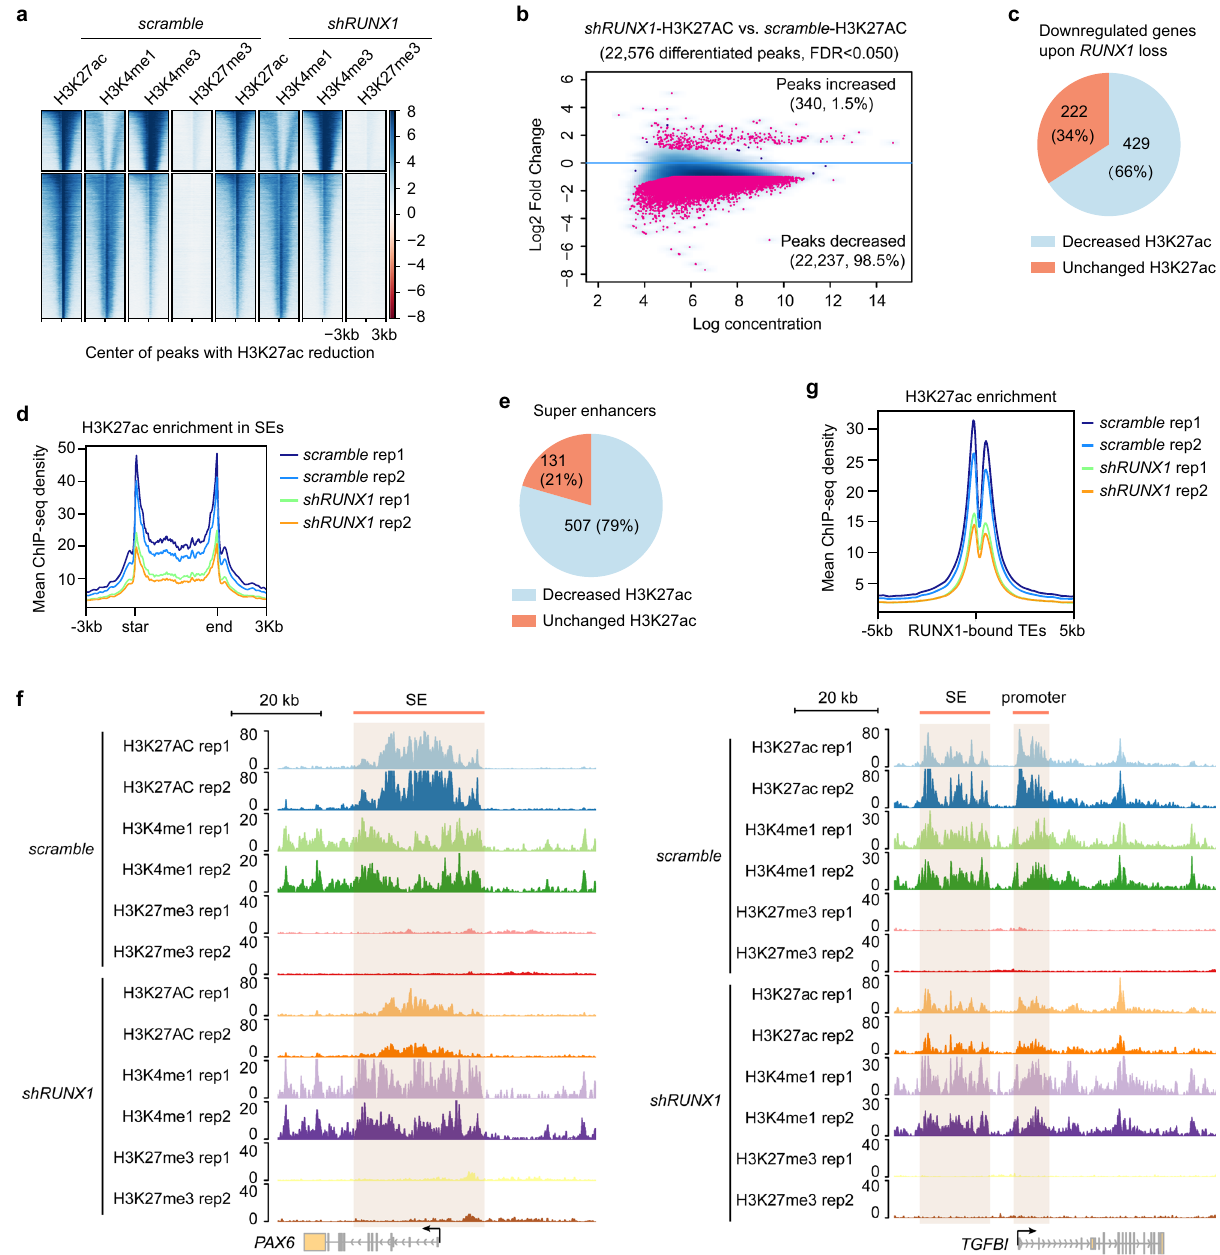
Fig. 5 RUNX1 depletion impairs H3K27ac deposition across lineage-speci fi c enhancers. a Heatmaps showing the indicated ChIP-seq signals across the peaks with H3K27ac reduction in shRUNX1 -treated versus scrambled shRNA-treated LSCs. b Scatterplot of H3K27ac enrichment in shRUNX1 -treated versus scrambled shRNA-treated LSCs. Sites identi fi ed as signi fi cantly differentially bound (fold change ≥ 2, FDR < 0.05) are shown in red. c Pie chart showing the percentages of reduced and unchanged H3K27ac signals close to the loci of down-regulated genes upon RUNX1 loss. d Metaplots of average H3K27ac density across the SEs of wild-type LSCs in shRUNX1 -treated and scrambled shRNA-treated LSCs. e Pie chart showing the percentages of reduced and unchanged H3K27ac signals across the SEs of wild-type LSCs upon RUNX1 loss. f Genome browser tracks for the indicated ChIP-seq signals across the PAX6 and TGFBI loci in scrambled shRNA-treated and shRUNX1 -treated LSCs. g Metaplots of average H3K27ac density across the RUNX1-binding TEs in scrambled shRNA-treated and shRUNX1 -treated